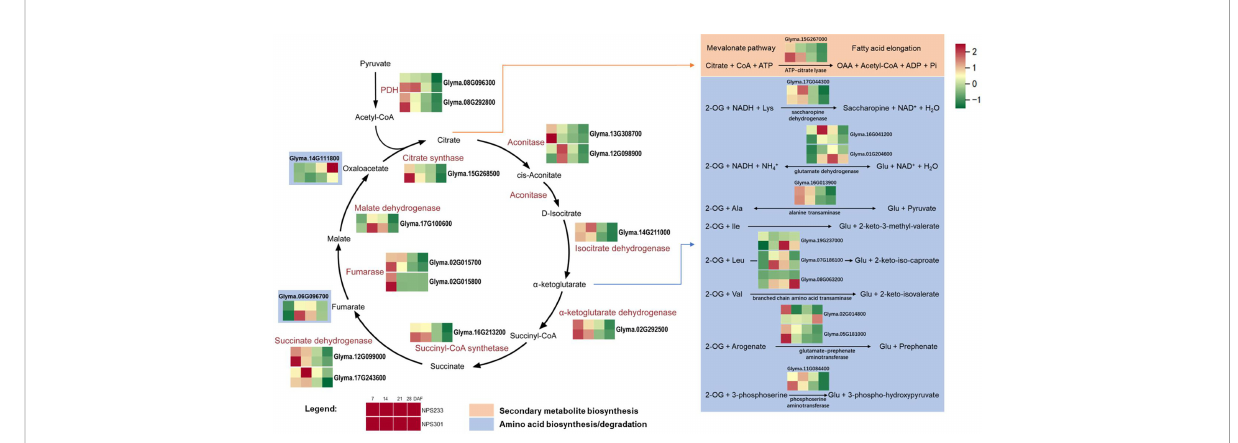
FIGURE 5 DEGs involved in Krebs cycle and the amino acids metabolic network it embedded in. Reactions are shown that consume or produce TCA cycle intermediates. For simplicity, co-enzymes are omitted from the TCA cycle. For each gene, squares denote expression patterns in each variety (see legend). Glyma.14G111800 , aspartate aminotransferase, Asp + 2-Oxoglutarate <-> Oxaloacetate + Glu, Glyma.06G096700 , argininosuccinate lyase, Argininosuccinate -> Arg + Fumarate. The gene per row is Z-score